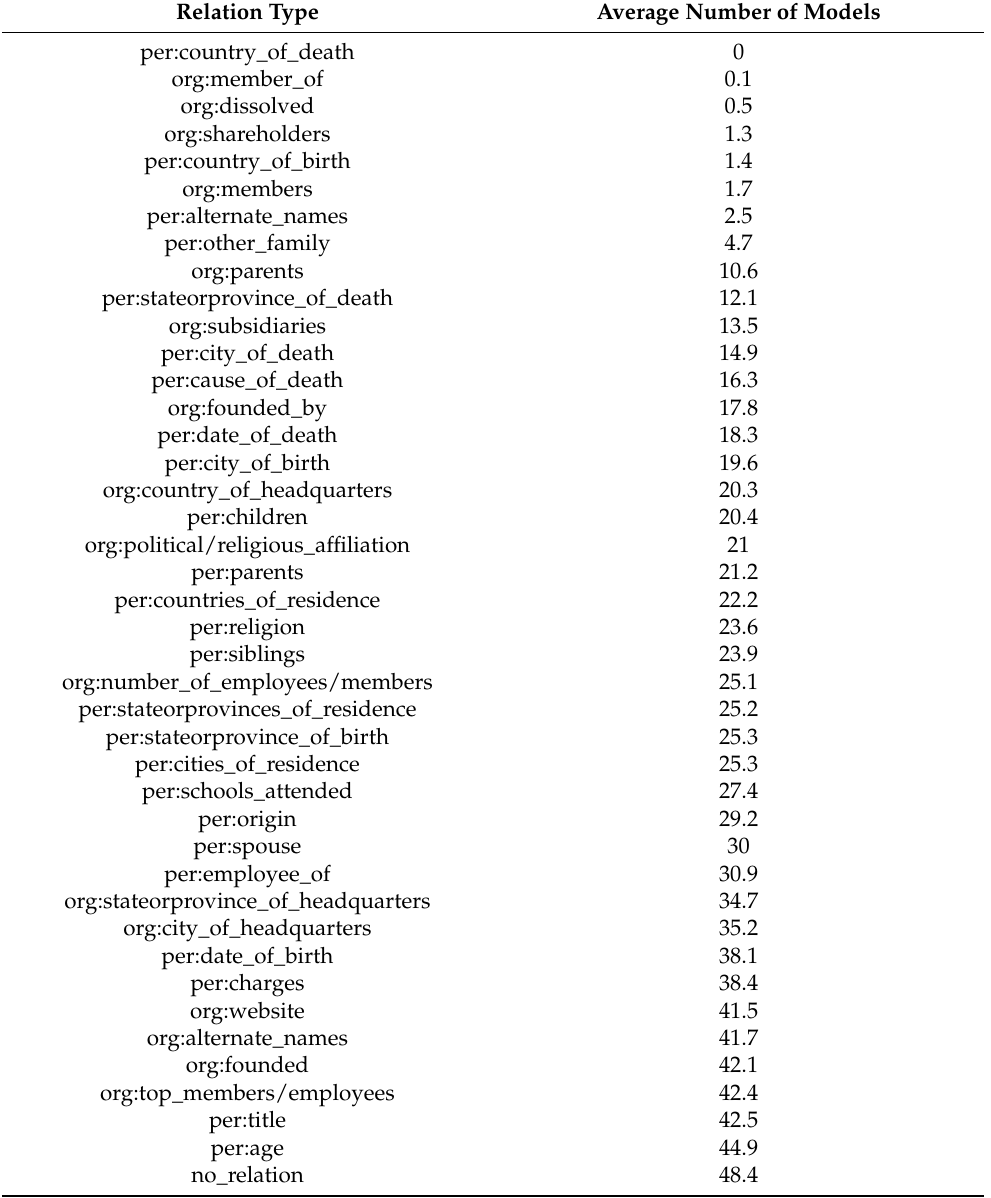
Table A4. The average number of models that correctly predict for each